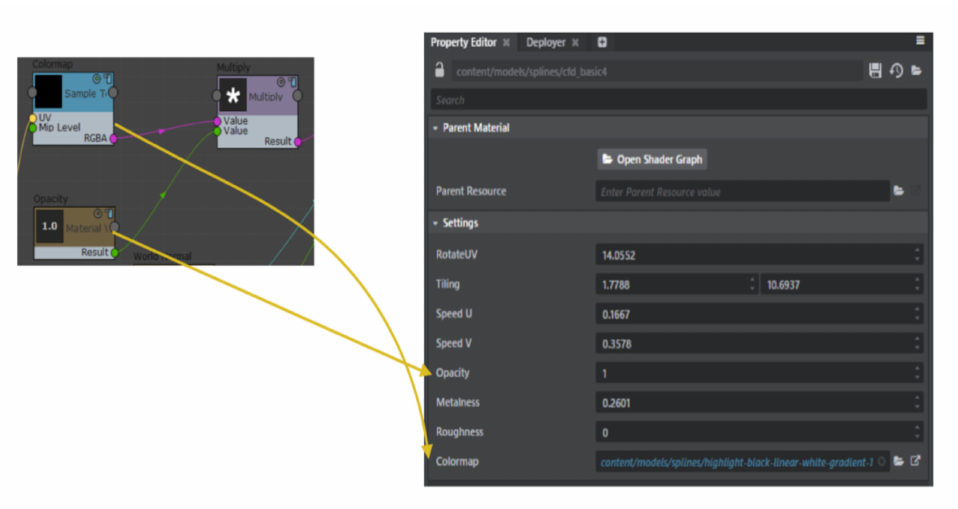
Figure A3. Step 2 in CFD animation material.